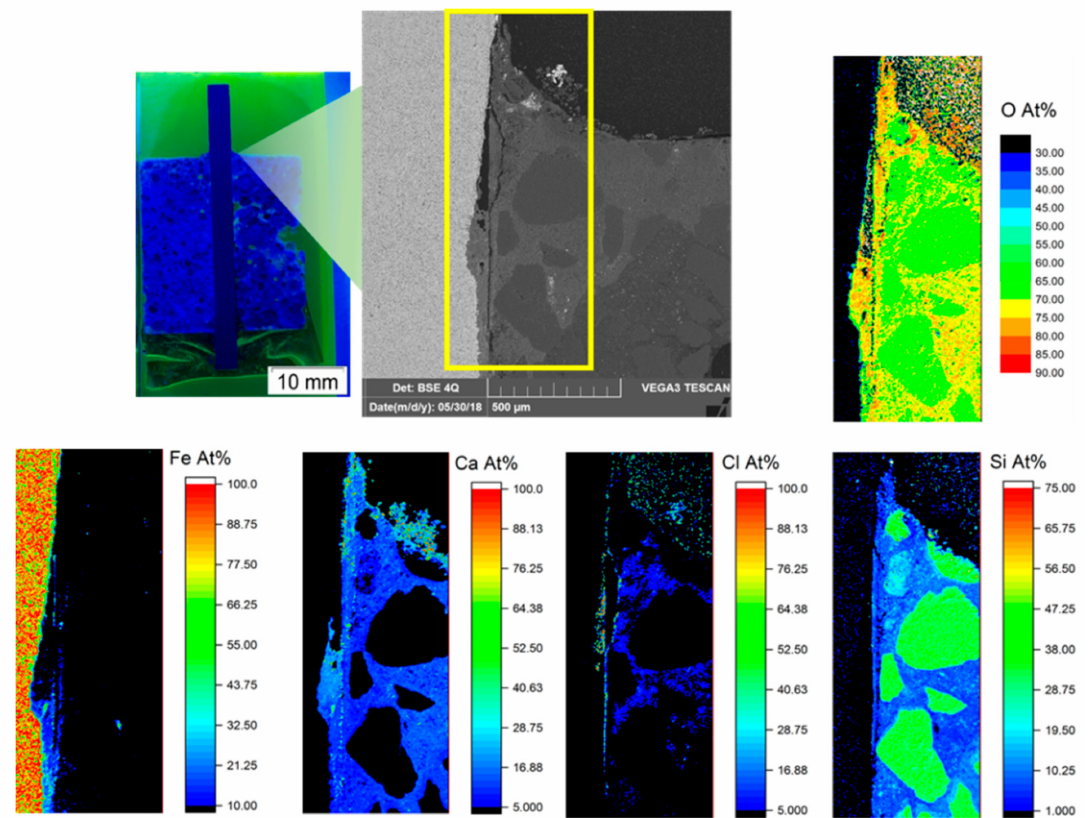
Figure 11. Element mapping at the 1.8977/Variodur interface by